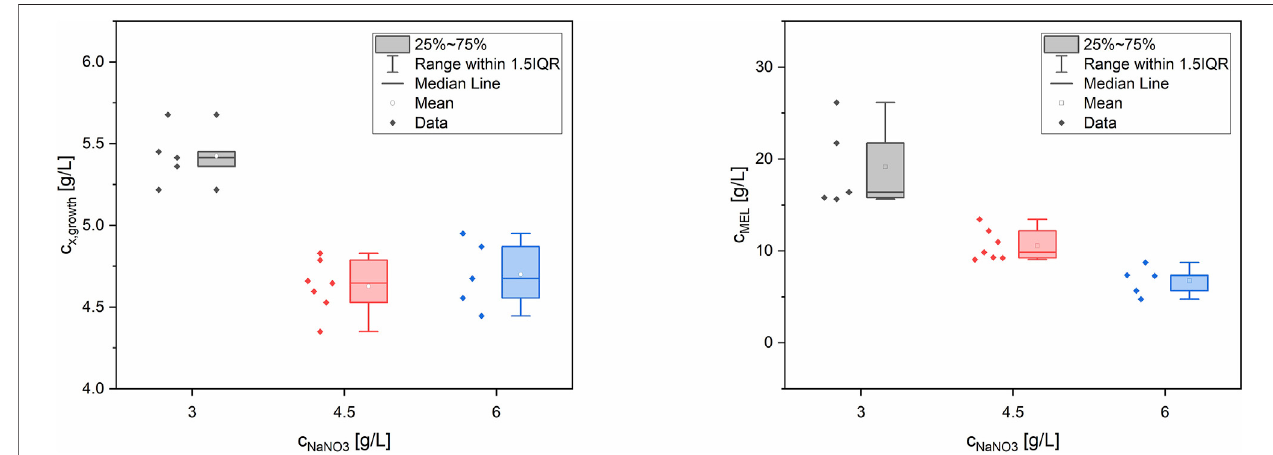
FIGURE2| Box-whiskerplotsforbiomass(left)andMELconcentration(right)dependingonNaNO 3 concentration inthemedium,ata fi xedglucoseconcentration of 30 g/L. The different concentrations of P and S were less or even not signi fi cant.